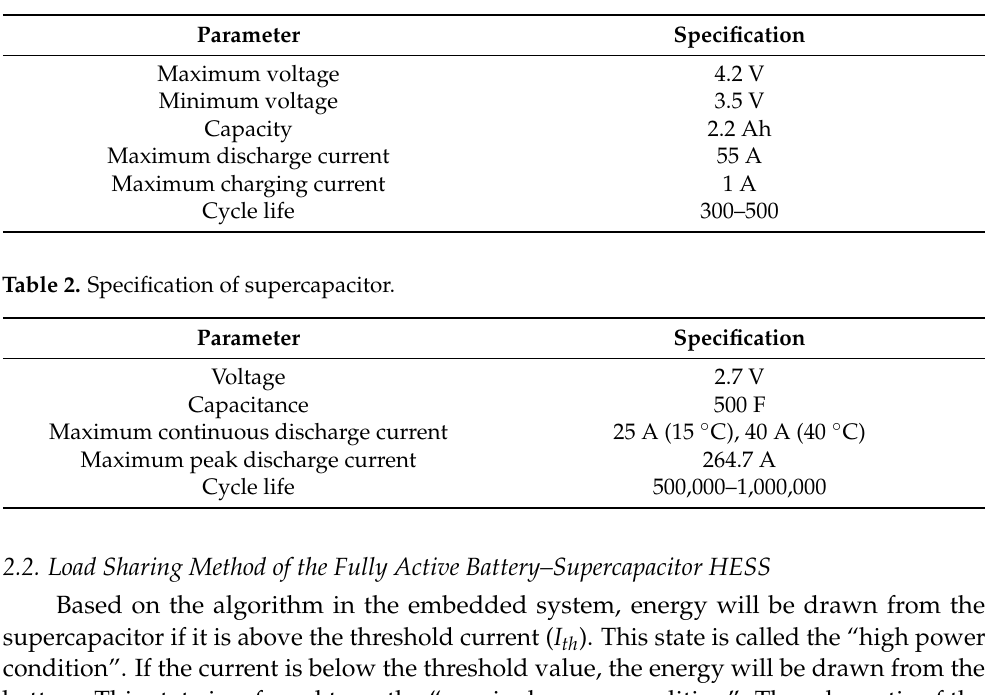
Table 1. Specification of lithium polymer battery.